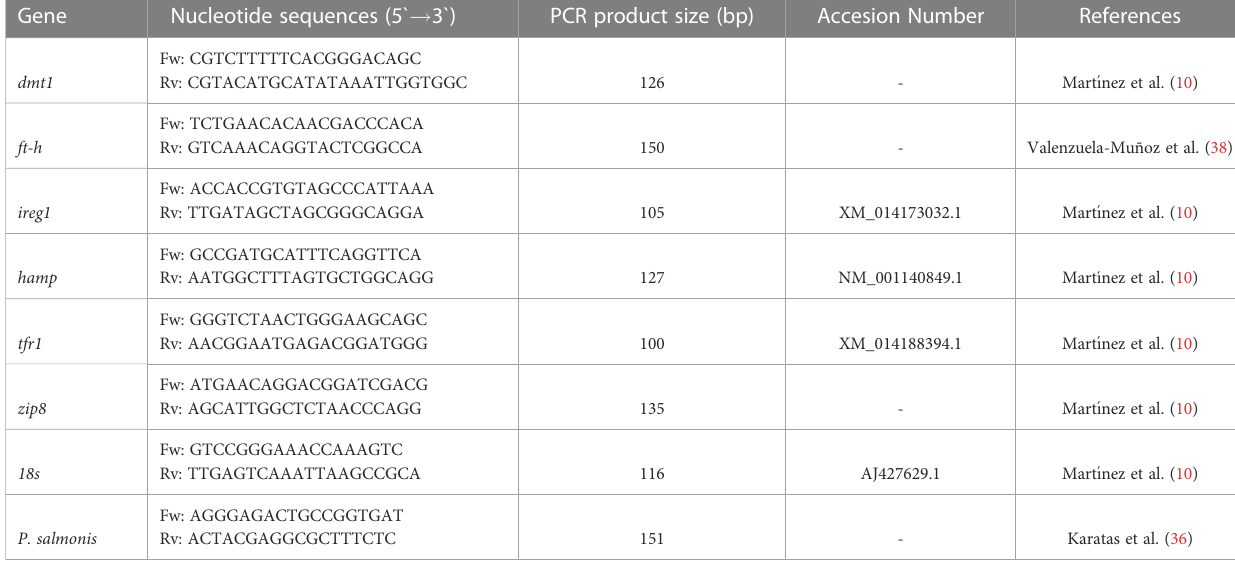
TABLE 1 Primer sequences. Gene